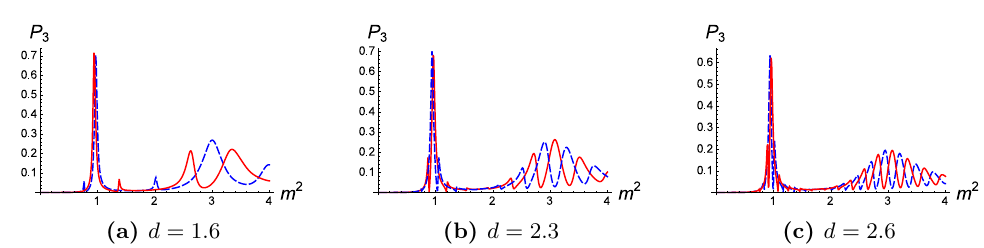
Figure 7. The relative probability P 3 ( m 2 ) of the even parity mode t e ( z ) (red solid lines) and the odd parity mode t o ( z ) (blue dashed lines) quasi-localized on the sub-branes for the double brane model (3.8). The parameters are set to k = 1, and b =